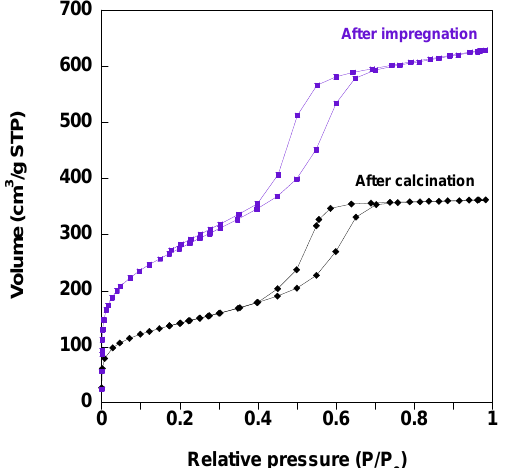
adsorption/desorption isotherms of the monoliths containing 2% wt of Co(II) Figure 7. N 2 ions after thermal treatment at 500 °C (black curve) and after impregnation in an acidic solution of K [Fe(CN) ] (violet curve). 3 6